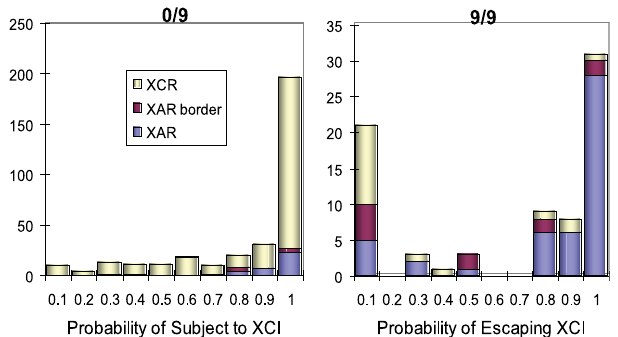
Figure 5. The Distribution of SVM Prediction Probabilities for Genes with Known X Inactivation Status These histograms summarize the prediction probabilities of genes that are either (A) subject to inactivation (expressed in zero of nine somatic cell hybrids) or (B) escape from inactivation (expressed in nine of nine hybrids) [12]. Genes from the XCR, XAR border genes, and nonborder XAR genes coupled with XAR ESTs are represented by different colors. XCI, X chromosome inactivation. DOI: